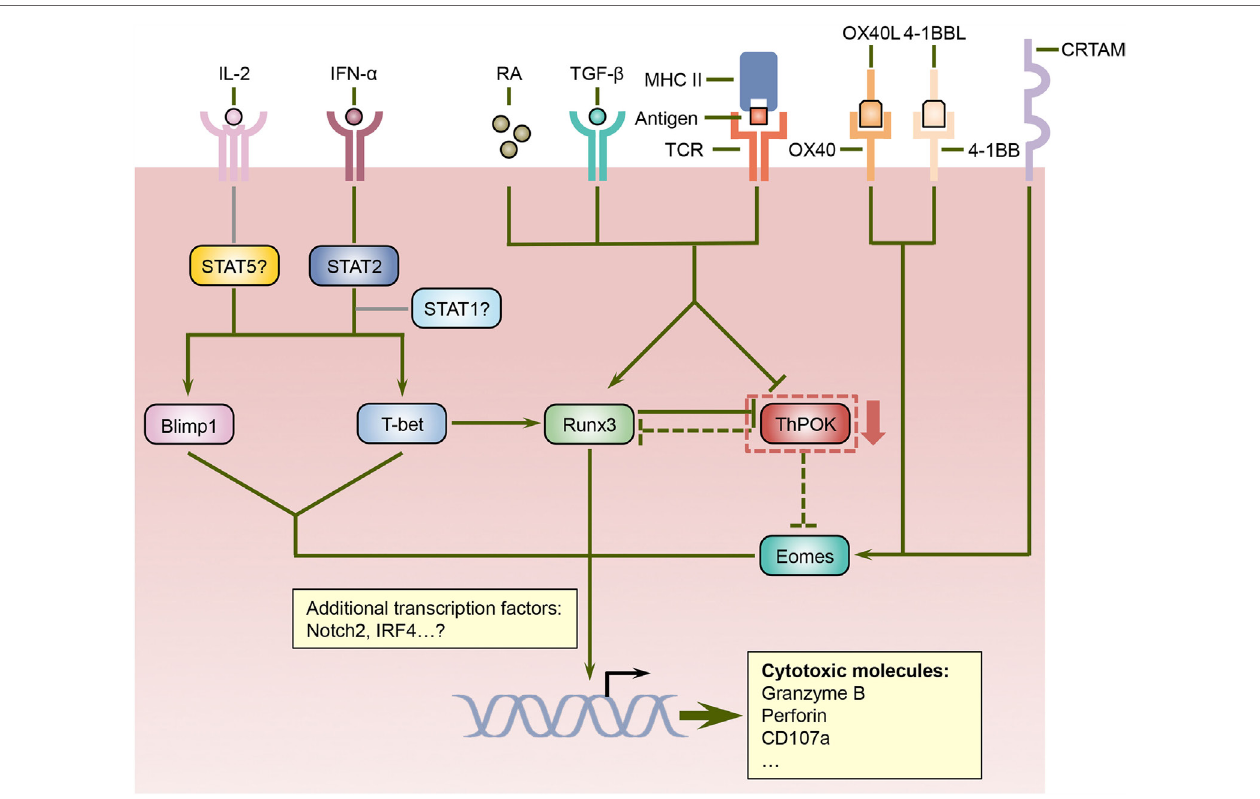
FiGURe 1 | Regulation of cytotoxic CD4 T cell differentiation by a network of signaling and transcriptional pathways . ThPOK is essential for the lineage specification and stability of CD4 helper T cells and counteracts Runx3, which coordinate the differentiation of CD8 T cells. Nevertheless, signals mediated by antigens, TGF- β , and retinoic acid (RA) can repress ThPOK expression in CD4 T cells, which results in elevated levels of Runx3. Since ThPOK inhibits Eomes, the suppression of ThPOK may also lead to increased Eomes expression. Furthermore, cytokines such as IL-2 and IFN- α , costimulatory molecules including OX40 and 4-1BB, as well as the transmembrane protein CRTAM can increase the expression and/or activities of Eomes as well as additional transcription factors such as Blimp1 and T-bet, which together with Runx3 direct the differentiation program of cytotoxic CD4 T